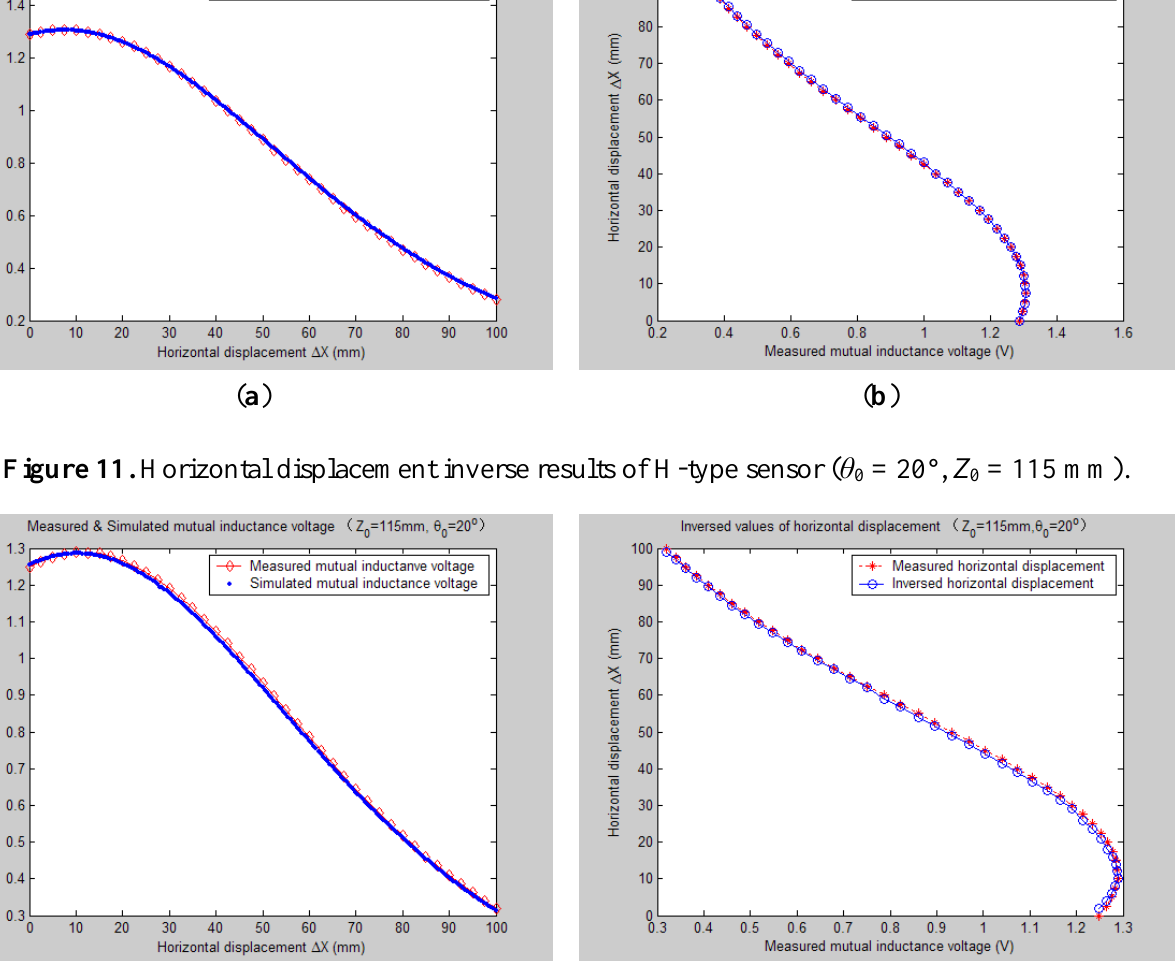
Figure 10. Horizontal displacement inverse results of H-type sensor ( θ